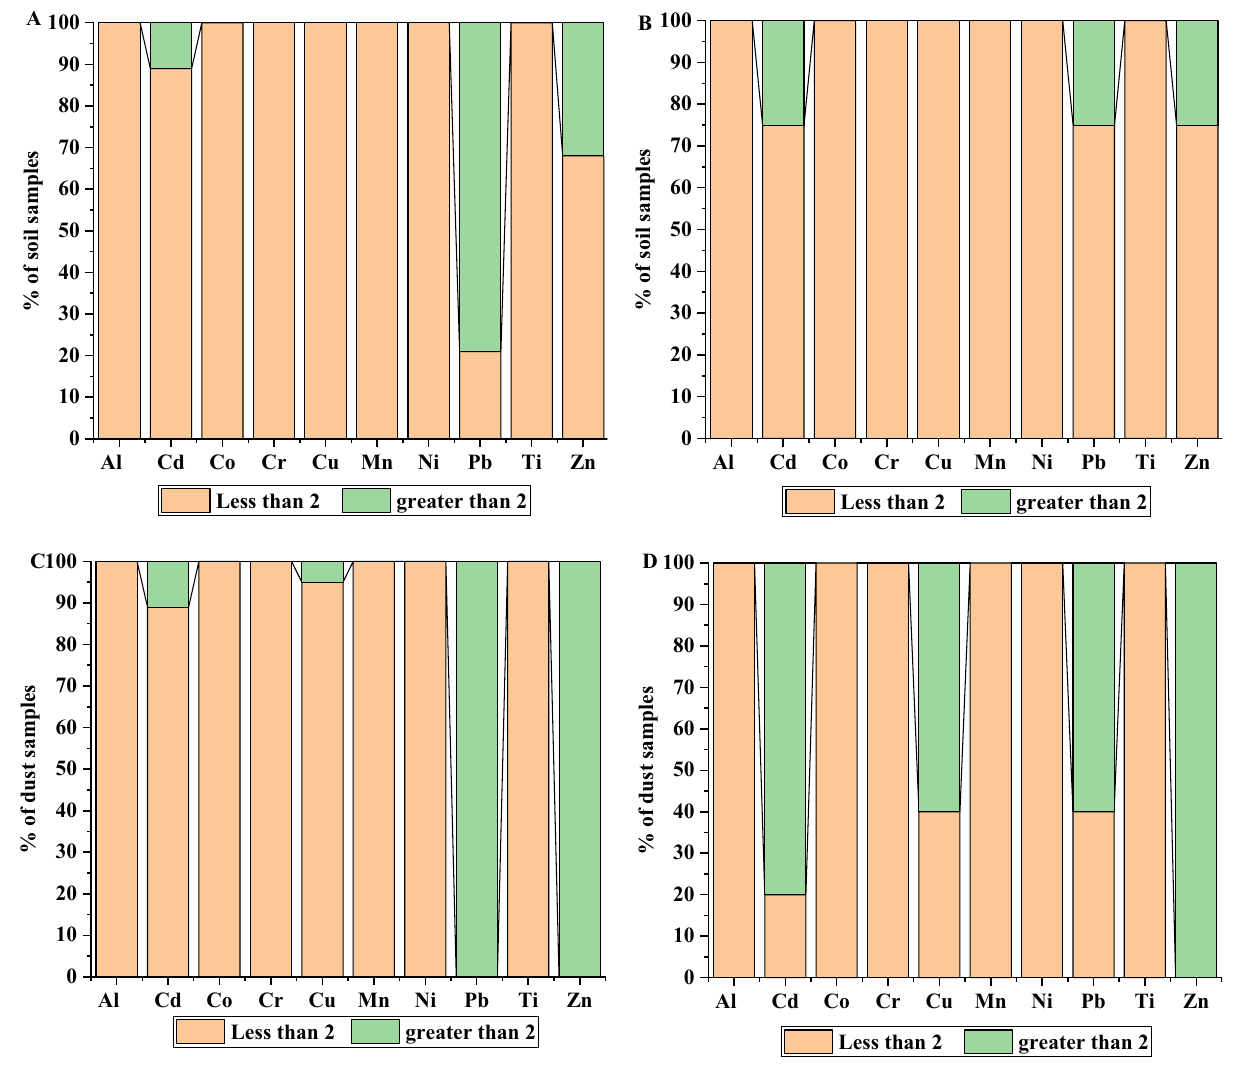
Figure 1. The average percentage of soil and dust samples having EF more or less than 2 [( A ) soil Riyadh; ( B ) soil Mahad AD’Dahab; ( C ) dust Riyadh; ( D ) dust Mahad